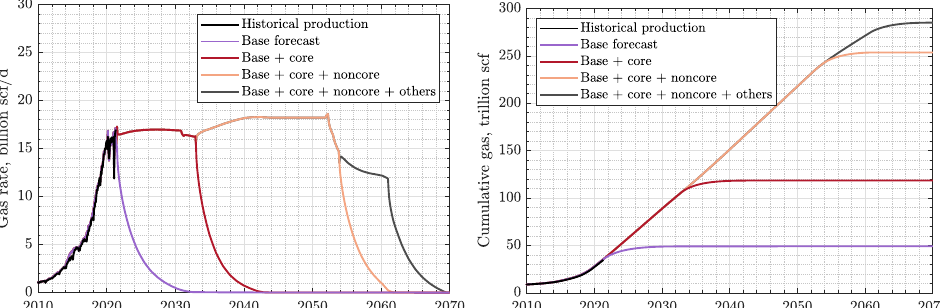
Figure 16. Infill forecast scenario for natural gas production in the Permian tight reservoirs. The total field EUR is 285 trillion scf or 246 trillion scf by neglecting the less profitable “Others”